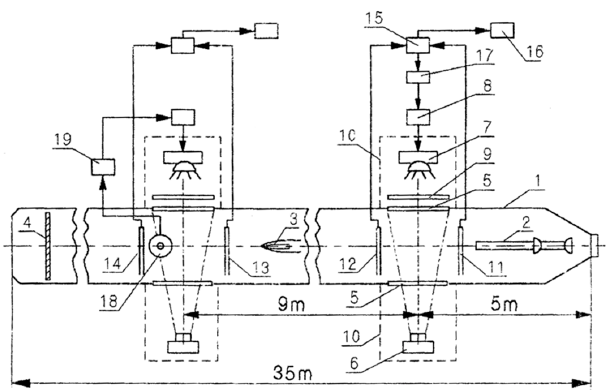
Figure 1. Schematic of the experimental setup: 1—launching tank; 2—electrochemical catapult; 3—